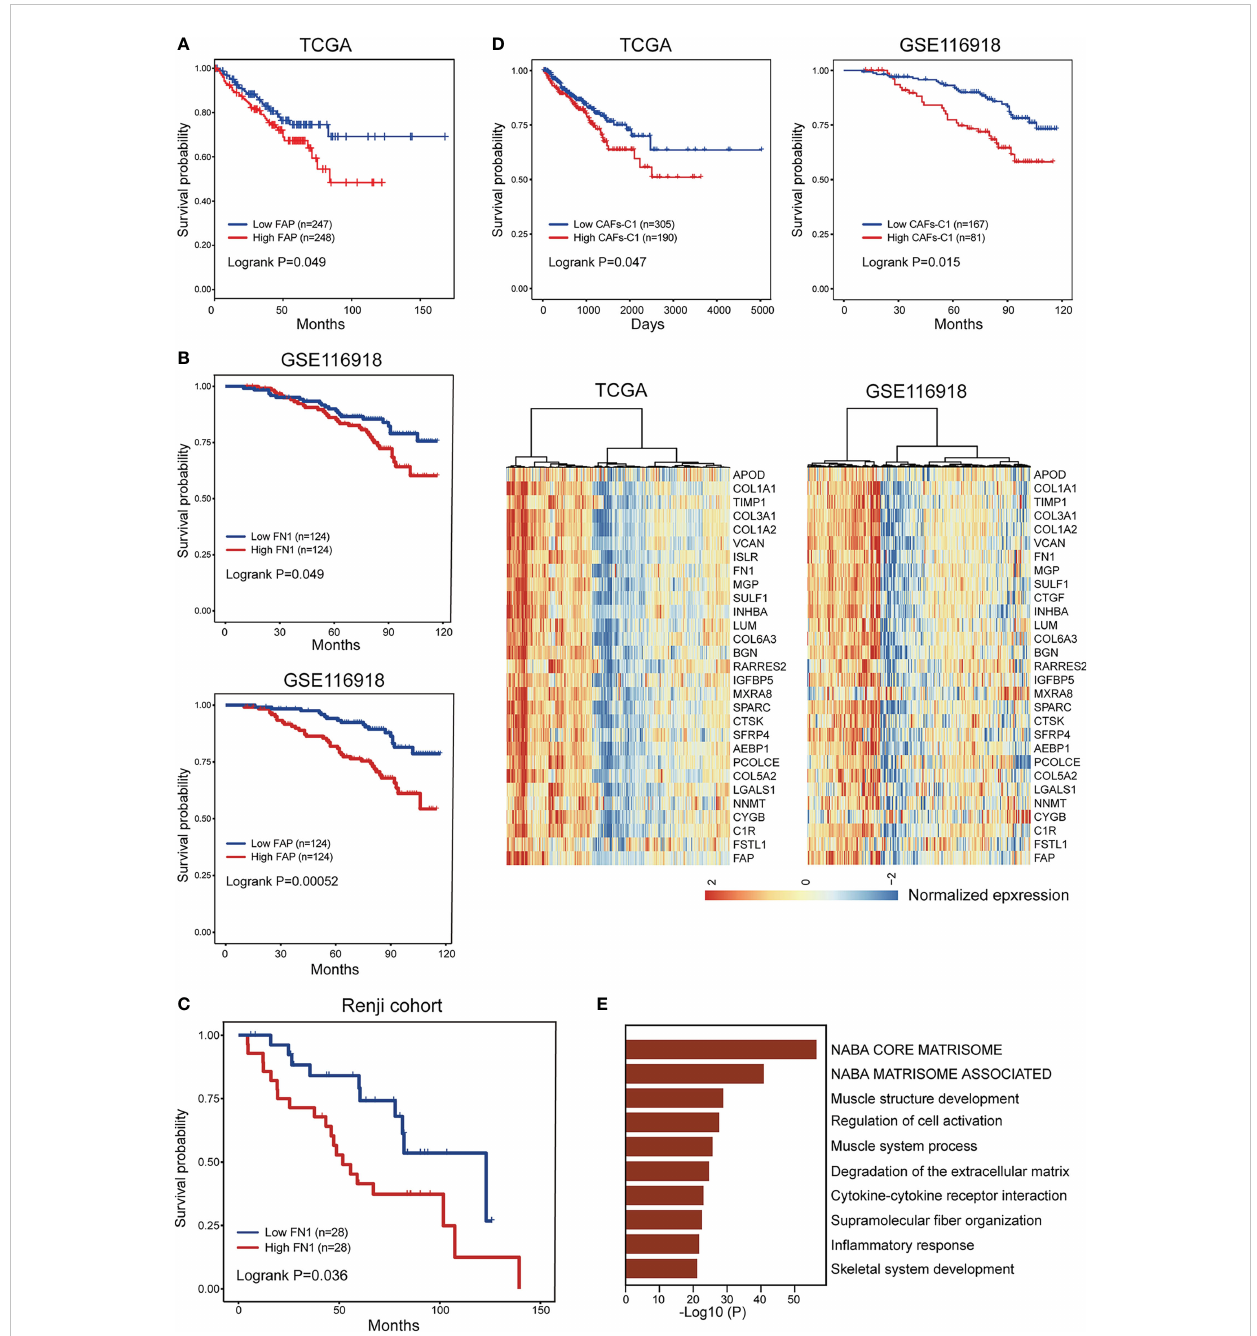
FIGURE 6 Prognostic signi fi cance of CAFs subtype signatures in prostate cancer. (A) The comparison of progression-free survival between patient subgroups divided by the expression level of FAP in TCGA-PRAD dataset. (B) The comparison of biochemical recurrence-free survival between patient subgroups divided by the expression levels of FN1 and FAP in GSE116918 dataset. (C) The comparison of biochemical recurrence-free survival between patient subgroups divided by the expression level of FN1 in Renji cohort. (D) Bottom. Hierarchical clustering de fi ned two CAFs-C1 subtypes based on the normalized expression pro fi les of 30 CAFs-C1 signature genes in TCGA-PRAD and GSE116918 dataset. Top. Kaplan-Meier analysis showed high CAFs-C1 represented an adverse prognostic factor in TCGA-PRAD and GSE116918 dataset. (E) The top ten enriched pathways for high CAFs-C1 samples from (D)